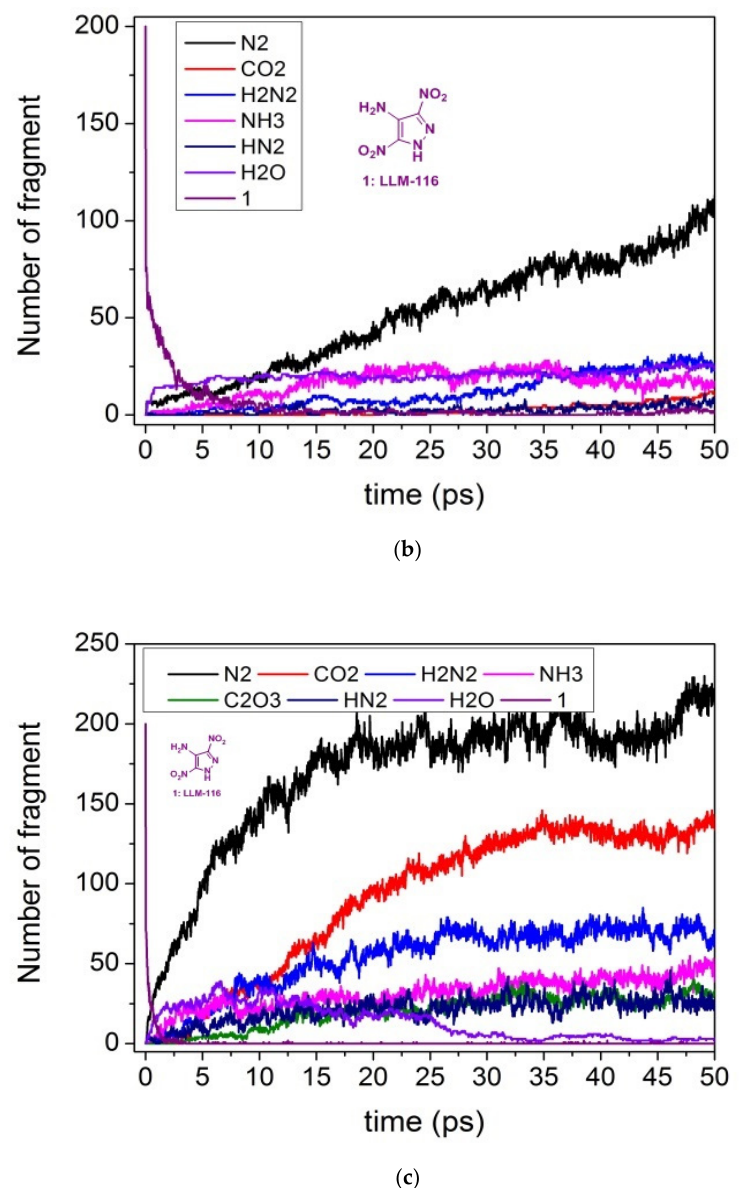
Figure 6. Evolution of key chemical species of LLM-116 (1) at 1500 K ( a ), 2000 K ( b ) and 3000 K ( c ).